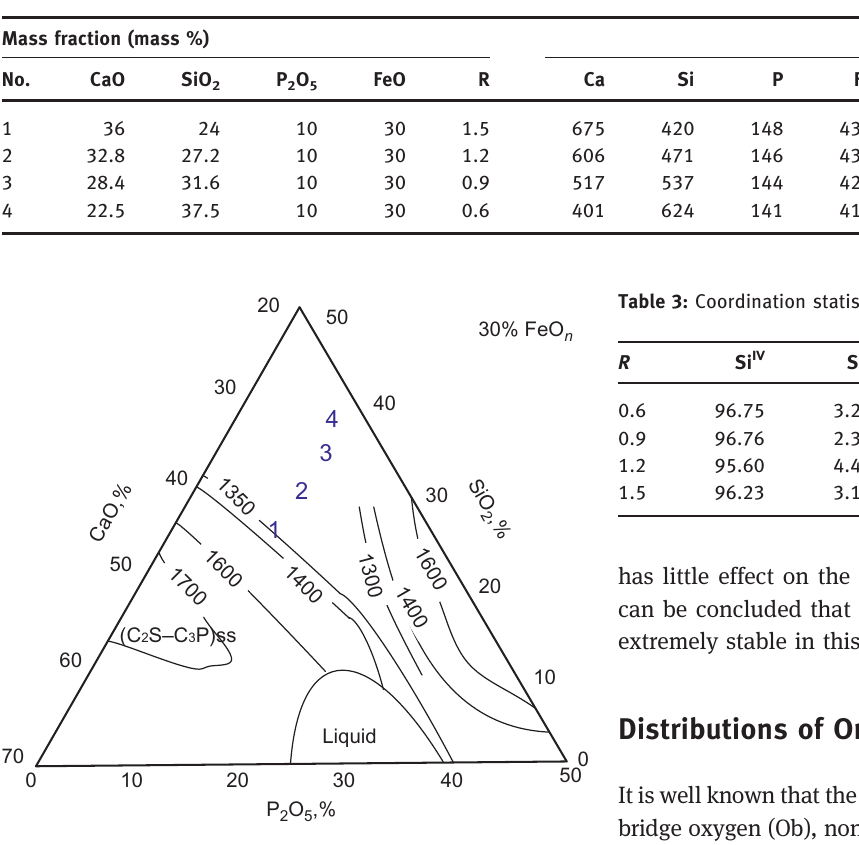
Figure 1: Slag compositions in CaO – SiO 2 – P 2 O 5 – FeO